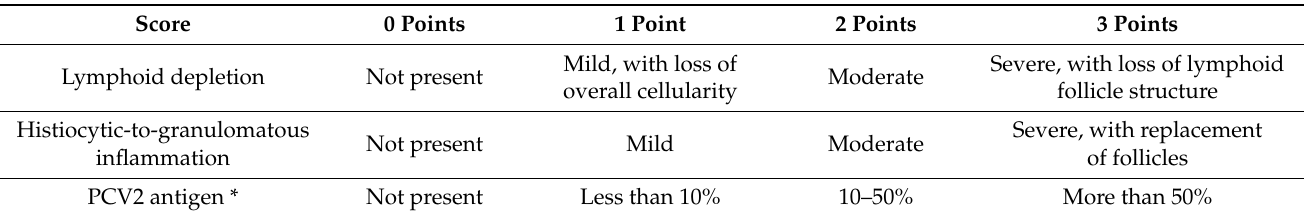
Table 2. Scoring system for the severity of PCV2-associated histologic lesions and amount of PCV2